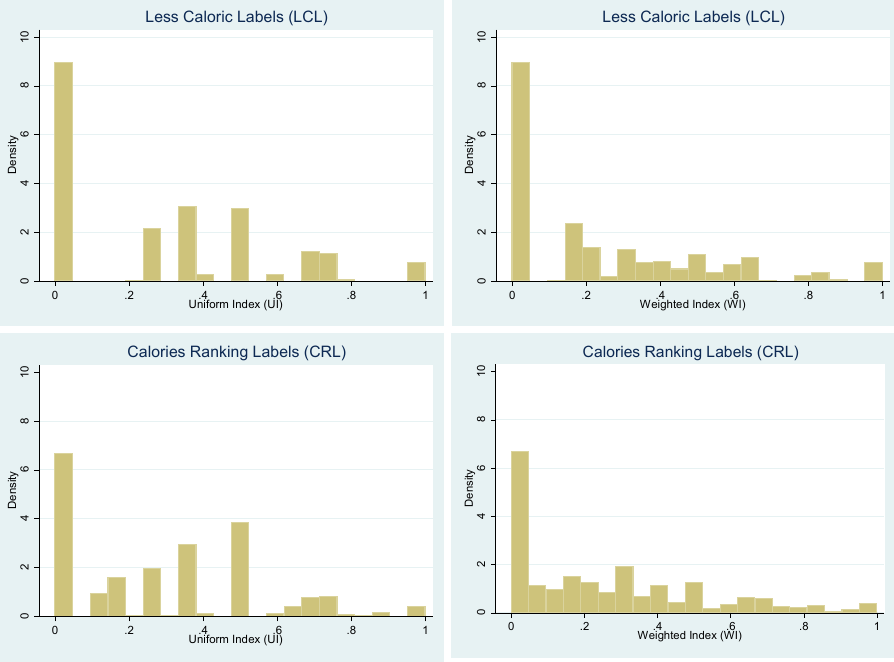
Figure 2. Distribution of the Weighted Index (WI) and Uniform Index (UI) for the Less Caloric Label (LCL) and Calories Ranking Labels